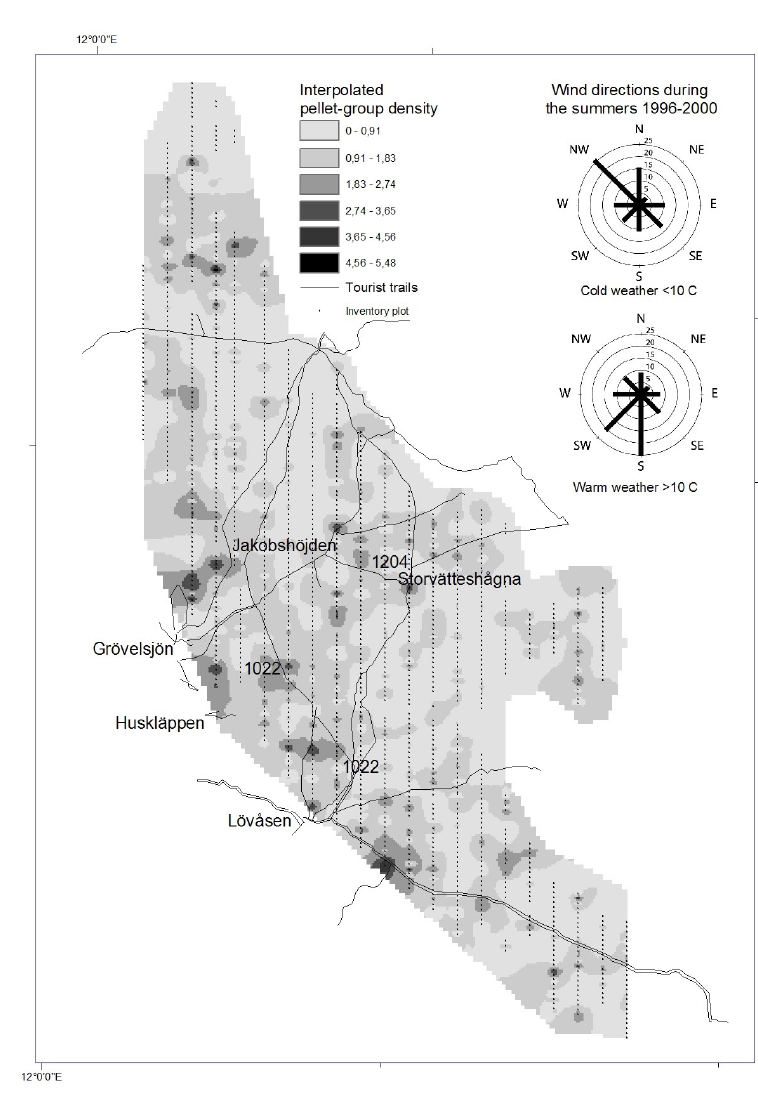
���������������������� Fig. 2. The pellet-group densities over Långfjället are visualized through an interpola- tion from inventory plots. The darker areas have a higher pellet-group density. The inventory plots are shown by the small plots. The wind directions for the period of 1996-2000 from June to September are shown for warm (>10 ºC) and cold (<10 ºC) weather, respectively. © Lantmäteriverket 1998. Ur GSD - Vägkartan, dnr